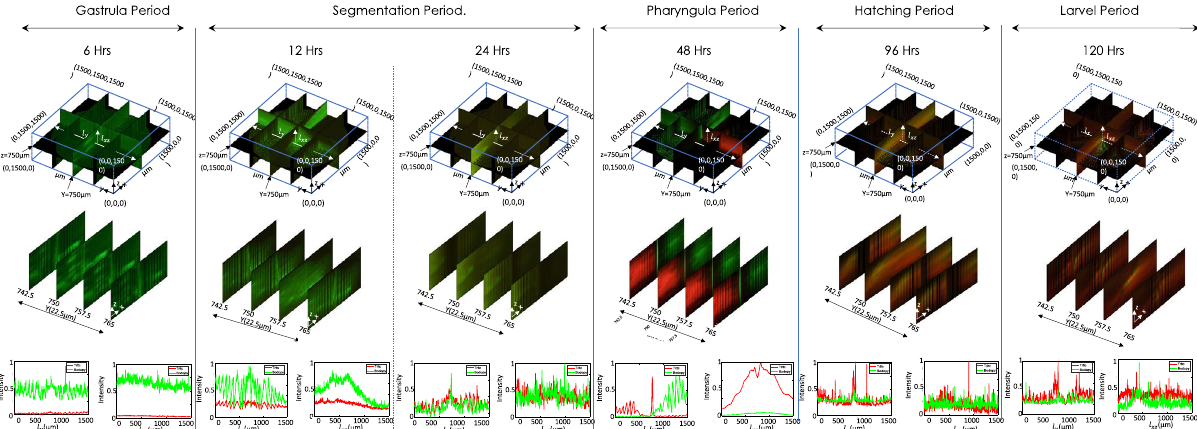
Figure 6. Zebrafish development at various phases indicating a cross-over from lipid-to-protein dependent metabolism. Intensity plot at 6 h period shows BODIPY dominating over TRITC indicating that muscle is yet not developed. At 12 h, there is a rise in TRITC level but dominated by BODIPY, whereas at 24 h significant amount of BODIPY and increased level of TRITC indicates growth of muscles. 48 h volume data shows significant amount of TRITC indicating developed muscles and localised yolk-sac (labeled by BODIPY). Finally, at 96 h and 120 h, BODIPY is localised and distributed over the prominent